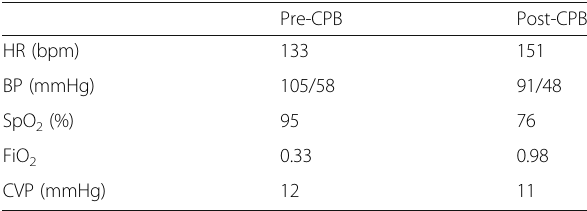
Table 1 Pre- and post-cardiopulmonary bypass hemodynamic